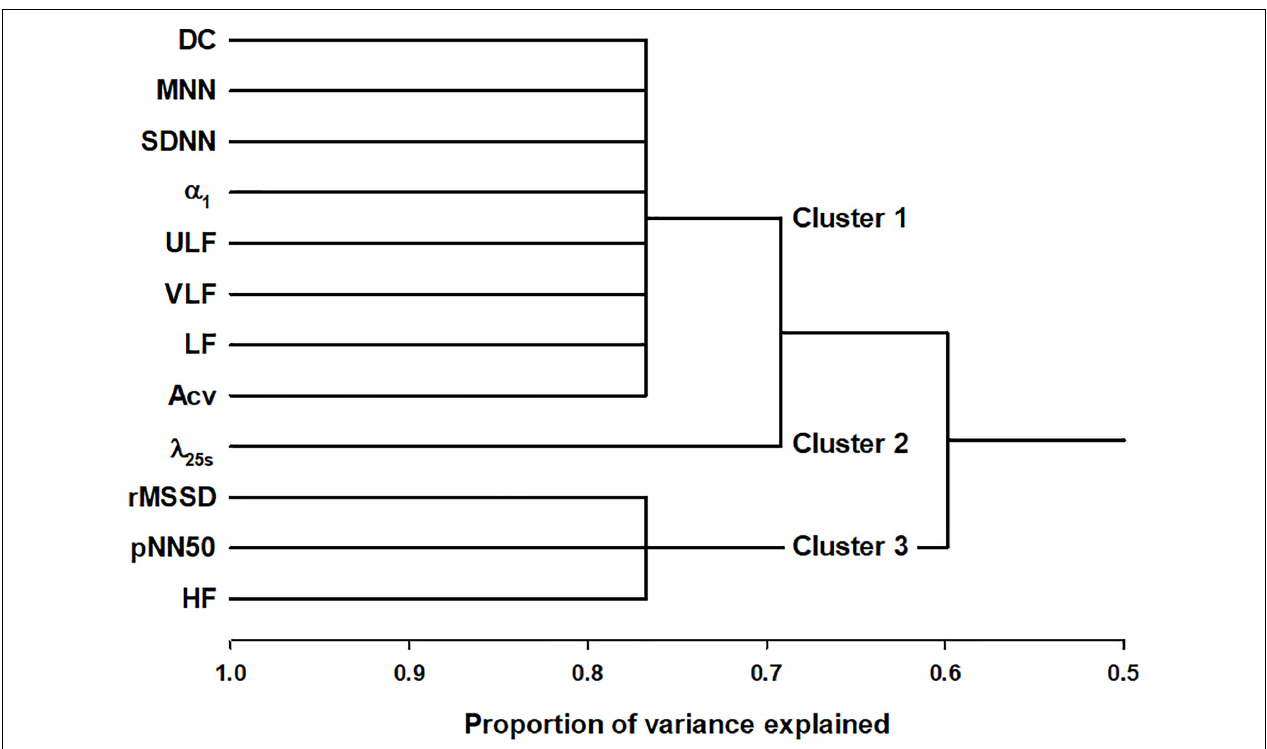
FIGURE 1 | Cluster analysis of HRV and HR dynamics indices in post-AMI patients. DC, deceleration capacity; SDNN, standard deviation of normal-to-normal R-R interval during 24 h; ULF, power of ultra-low-frequency ( < 0.0033 Hz) component; VLF, power of very-low-frequency (0.0033–0.04 Hz) component; LF, power of low-frequency (0.04–0.15 Hz) component; Acv, amplitude of the cyclic variation of heart rate; λ 25s , non-Gaussianity index for a segment length of 25 s; Fcv, frequency of the cyclic variation of heart rate; rMSSD, root mean square of successive R-R interval differences; pNN50, percentage of successive R-R intervals differing > 50 ms, and HF, power of high-frequency (0.15–0.40 Hz)